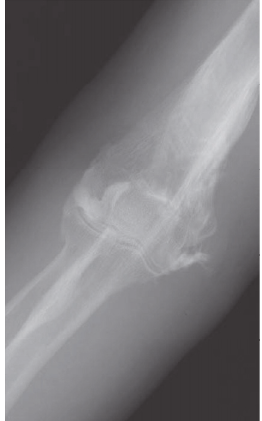
Figure 5: The elbow arthrography revealed a complete tear of the medial collateral ligament and a suspected partial tear of the lateral collateral ligament.